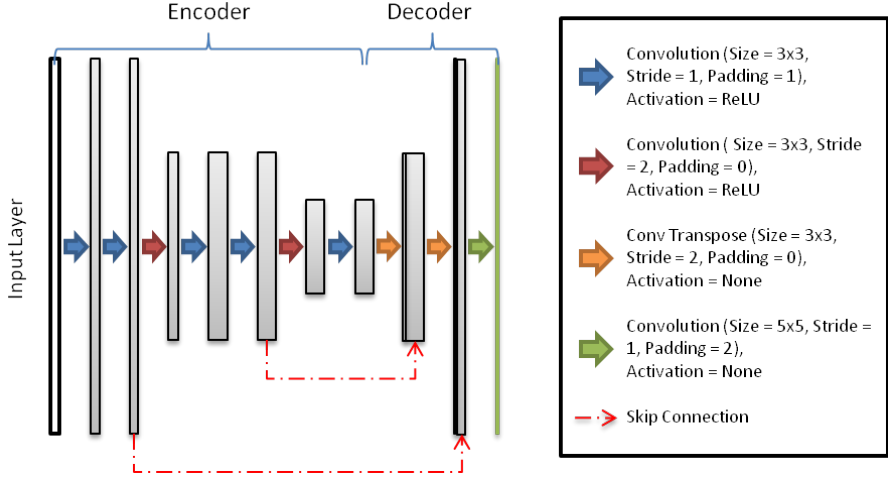
Figure 2. Visualized structure of U-net